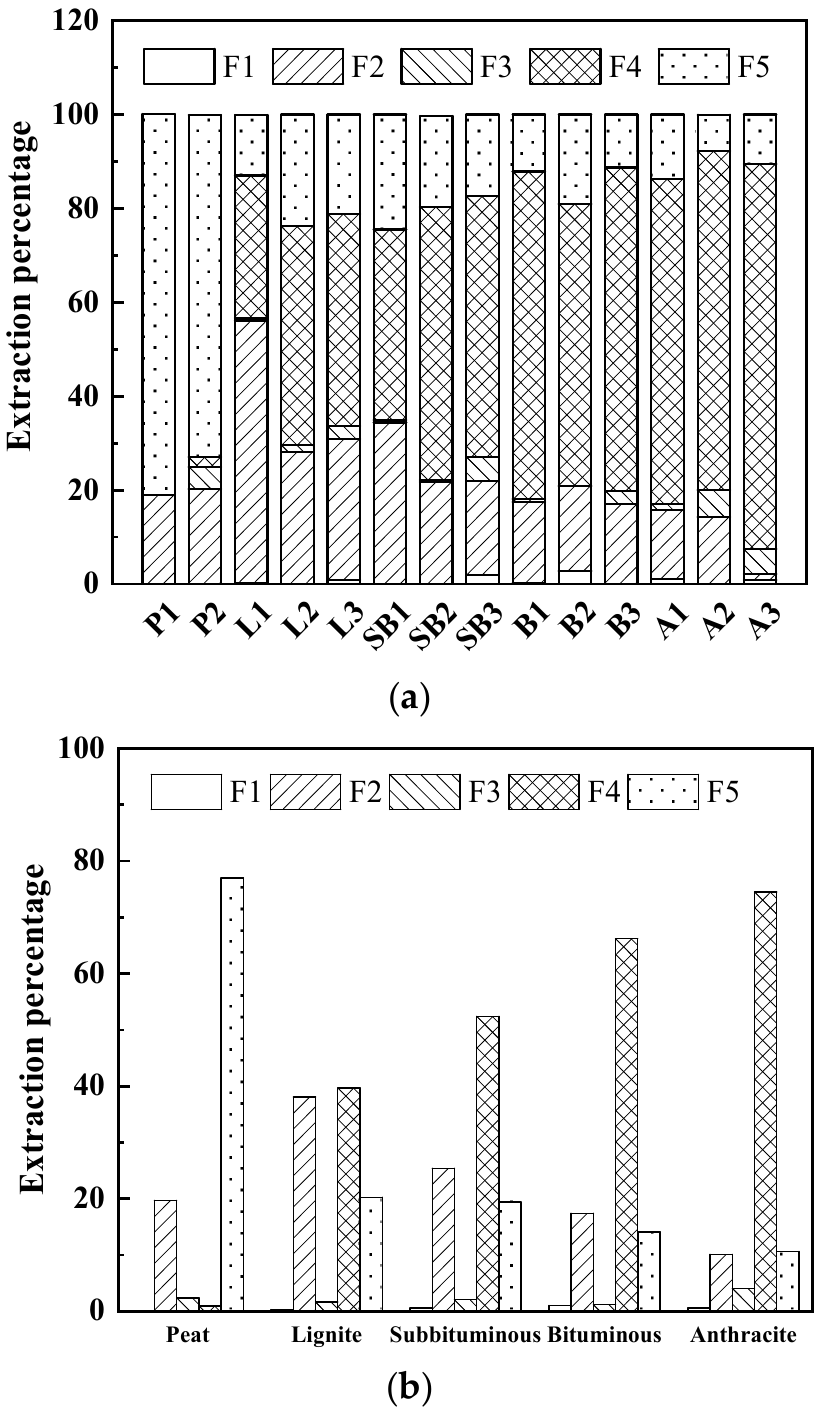
Figure 6. Distribution characteristics of five Hg species in coals. ( a ) Individual result of 14 coal samples. ( b ) Average value of coals with the same